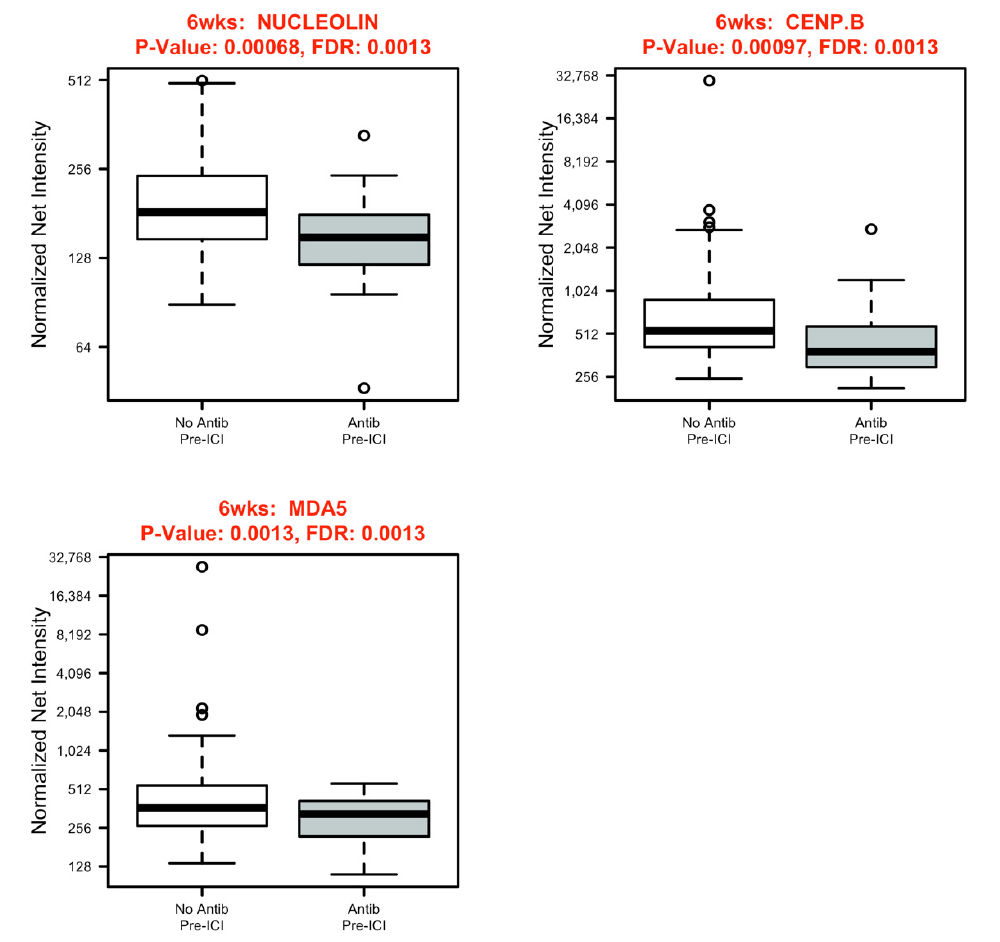
Figure 2. Autoantibodies with statistically significant differences ( p < 0.05, FDR < 0.2) according to antibiotic exposure: ( a ) baseline; ( b ) 6 weeks.